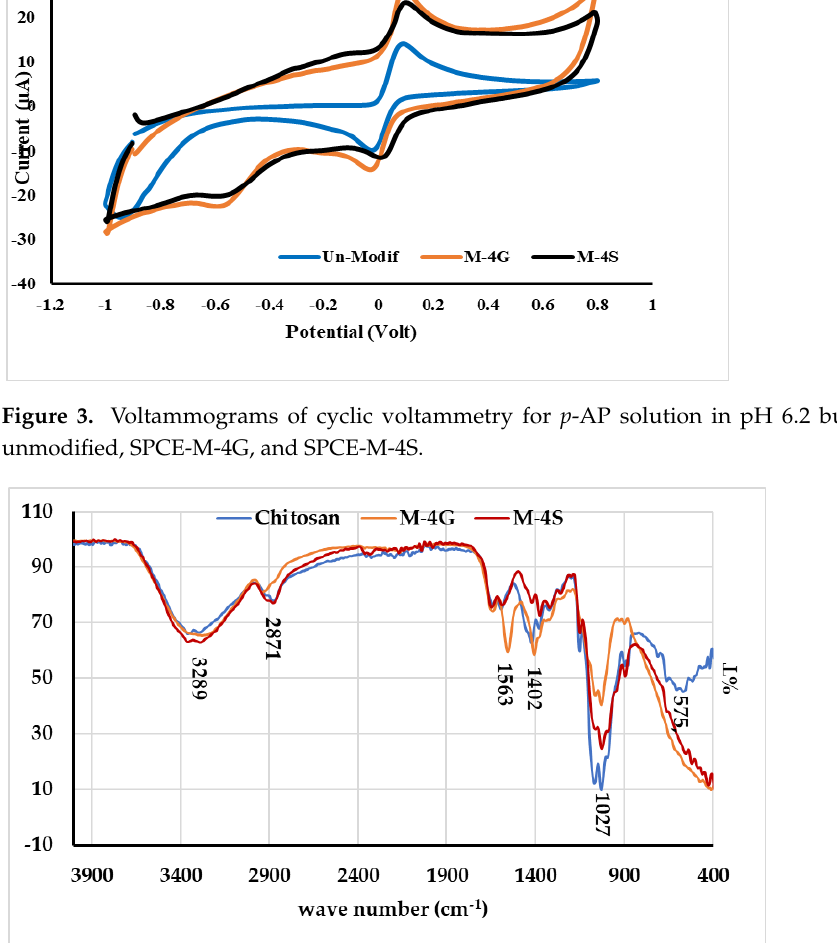
Figure 4. FTIR spectra for chitosan, MIP-glutaraldehyde (M-4G) and MIP-STPP (M-4S). Table 2. Wavenumbers and functional groups of chitosan and